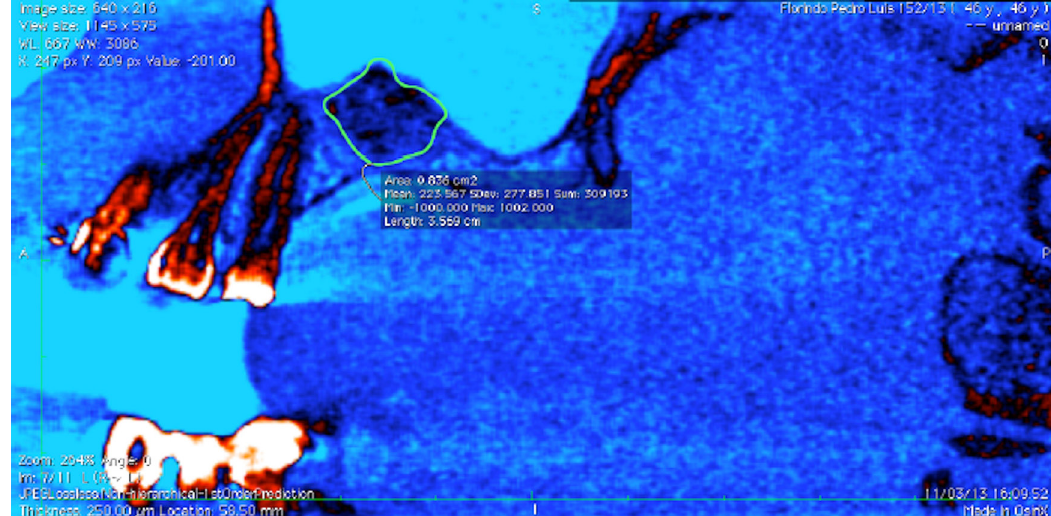
Figure 1- Example of an image used to measure the volume of Biogran ® graft, generated by the OsiriX software. The contour of the graft in the computed tomography slice is bounded in green, and the area is evaluated automatically by the